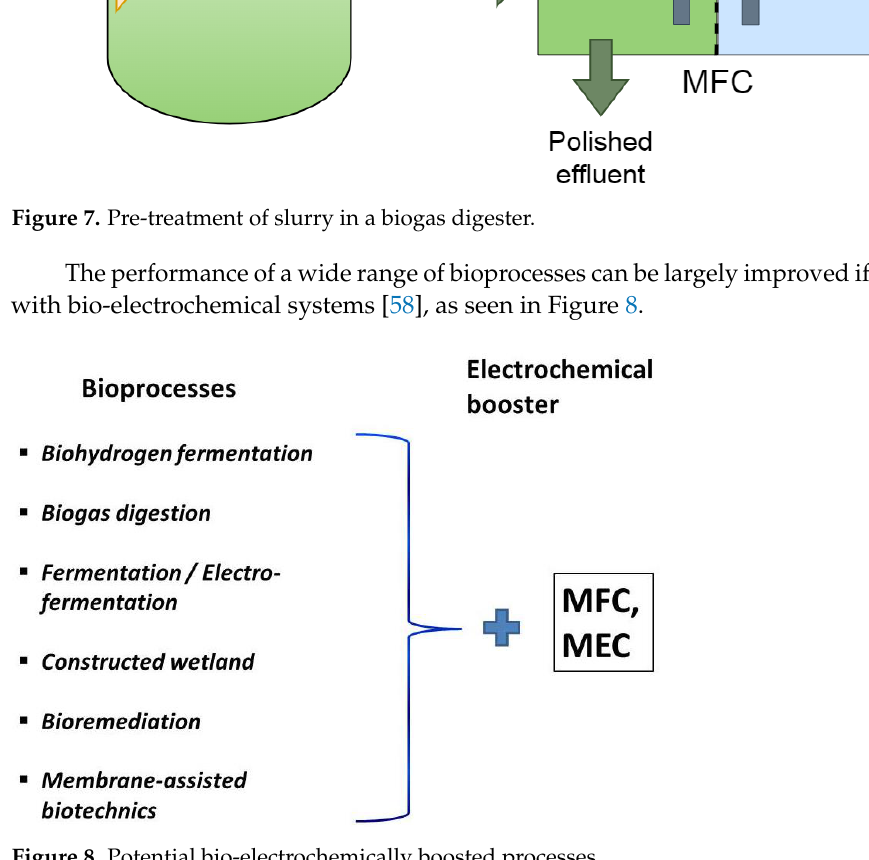
Figure 7. Pre-treatment of slurry in a biogas digester.